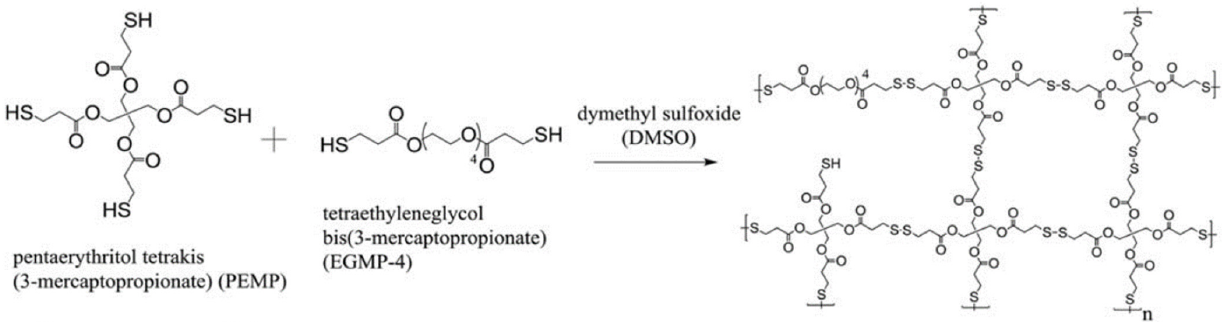
Figure 16. Formation of crosslinked copolymers of PEMP and EGMP-4. Adapted with permission from [25]. Copyright (2017) Wiley Periodicals, Inc.